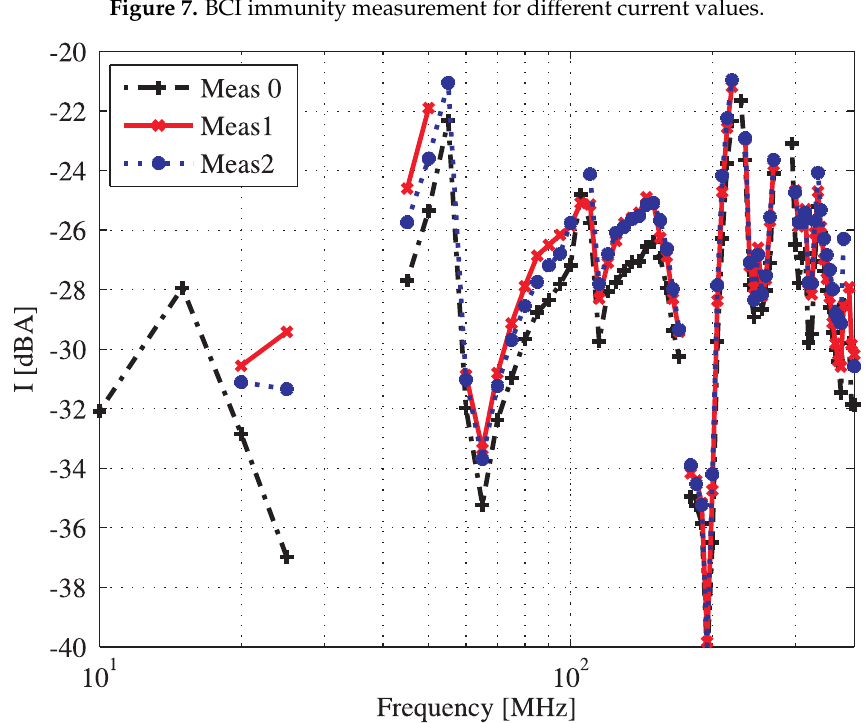
Figure 8. BCI immunity measurement for different caps presence in layout in Figure 2: Meas0 = no caps; Meas1 = C + , C − ; and Meas2 = C + , C − , C H _ VOUT , C H _ VDD